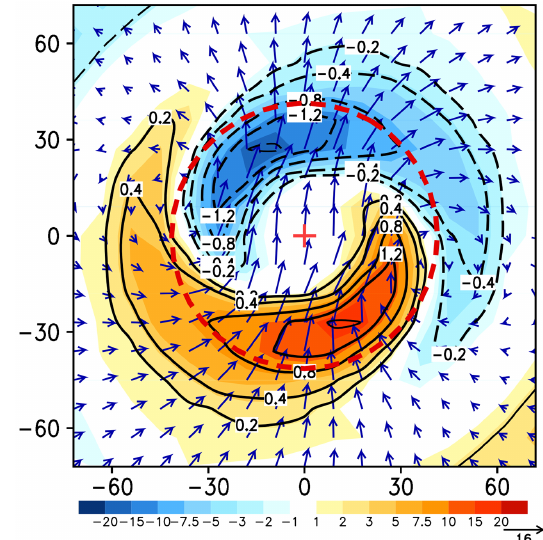
Figure 10. The wave-number-one components of the 500hPa verti- cal motion (contours, ms − 1 ) , 700hPa winds relative to the tropical cyclone motion (vectors, ms − 1 ) and 500hPa heating rate (shaded, 10 − 4 Ks − 1 ) after 18h of integration. The dashed circle indicates the radius of maximum